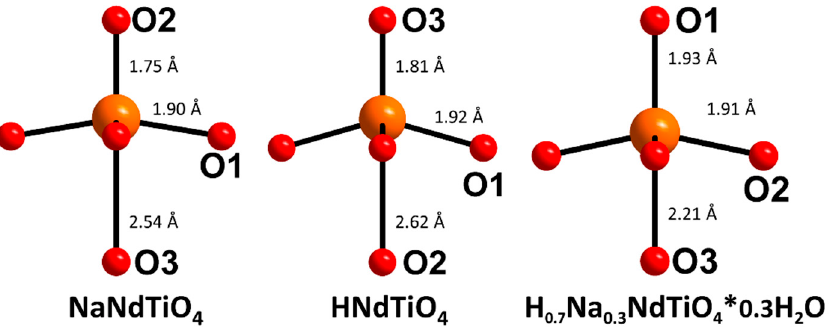
Figure 8. Titanium-oxygen octahedron geometry in the case of NaNdTiO 4 (data from [42]), HNdTiO 4 (this work) and H 0.7 Na 0.3 NdTiO 4 · 0.3H 2 O (this work). The titanium-oxygen bond lengths are shown in the figure.